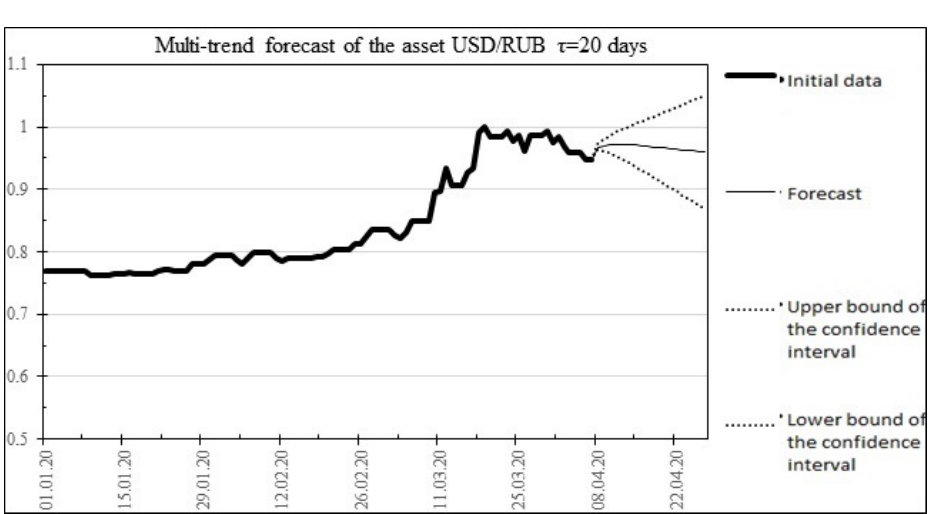
to historical asset price data. τ